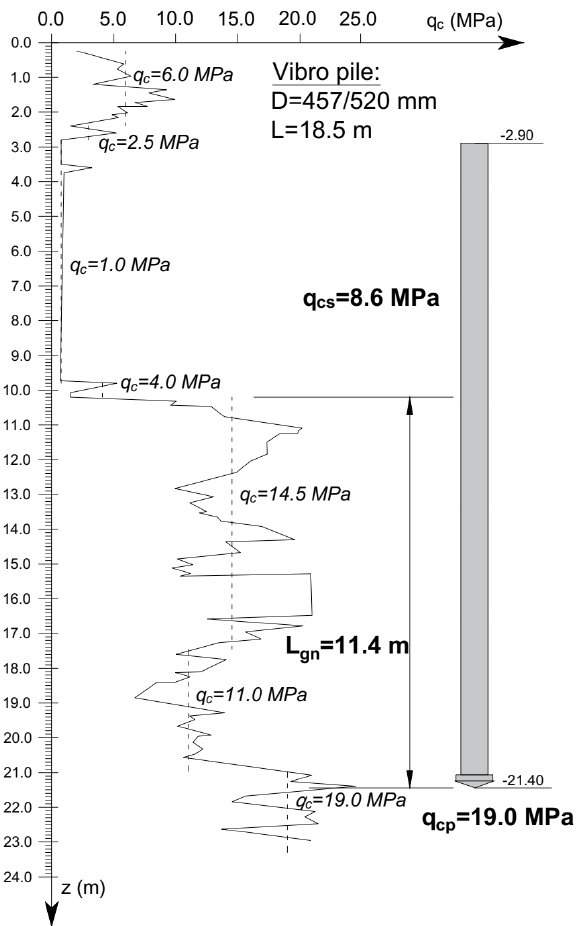
Figure 7: Results of probing and averaged parameters from CPT testing.